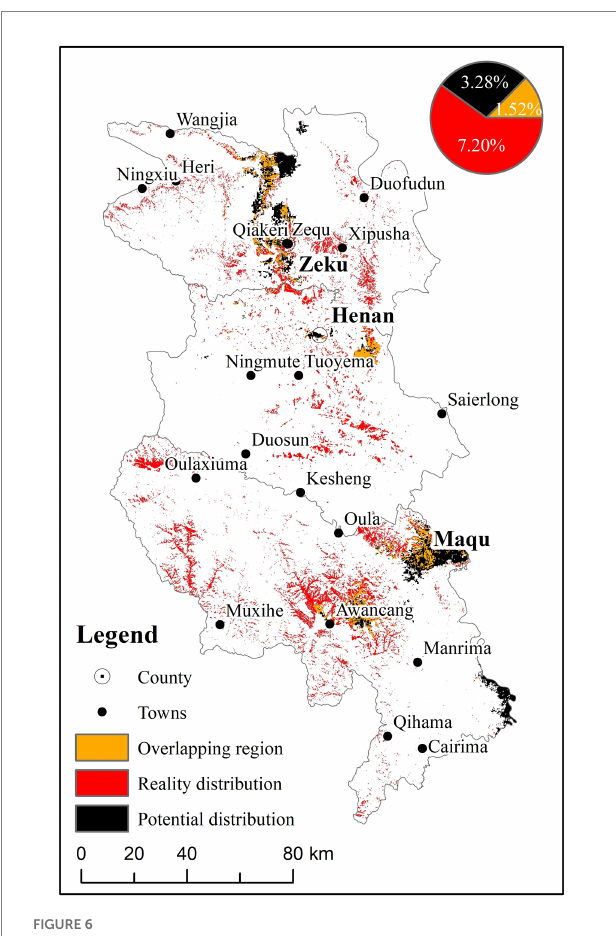
FIGURE 6 Reality and potential spatial distribution of Kobresia pygmaea